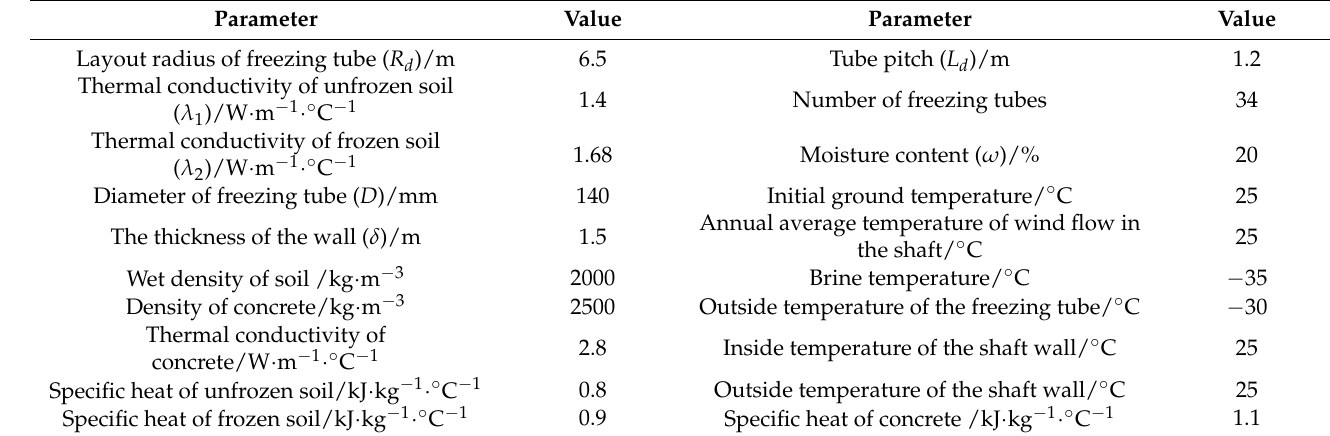
Table 5. Typical parameter values in the full combination